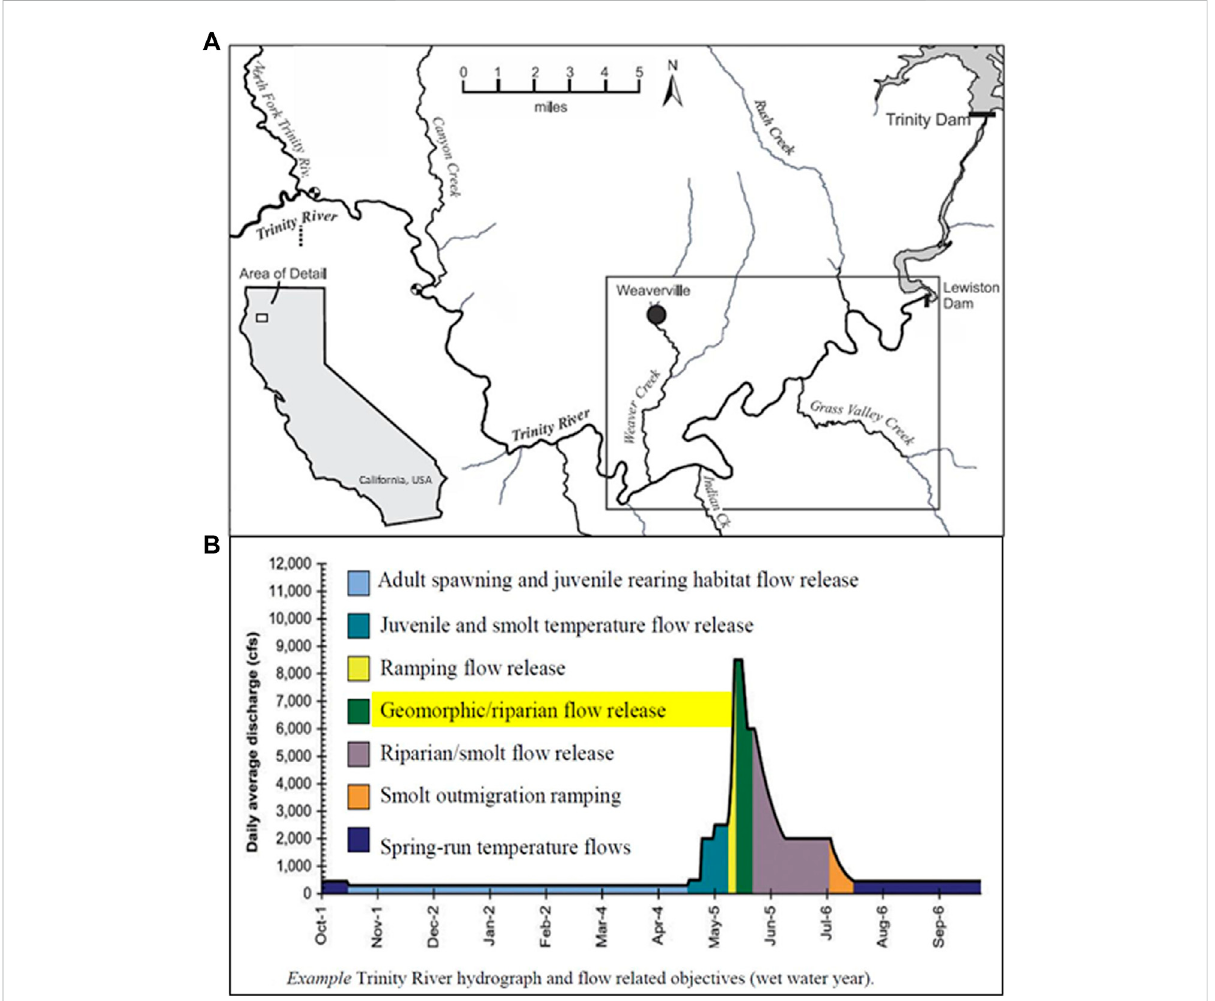
FIGURE 6 (A) Map of the Trinity River between Lewiston Dam and the North Fork Trinity River where restoration activities have been focused since 2004. Gravel augmentation efforts have been focused in the boxed portion of the river, which is shown in greater detail in Figure 5. Reproduced from (Gaeuman, 2020). (B) Exampleof environmental fl ow regime and fl ow-relatedobjectives proposed for “ wet ” water year types under theTrinity River Restoration Program. Reproduced from (TRRP,